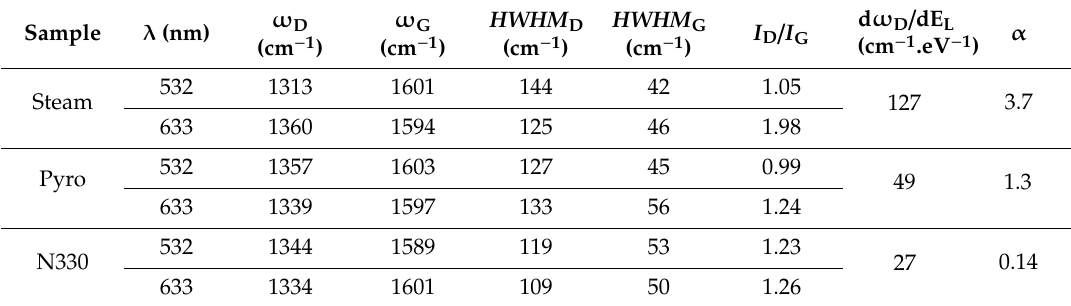
Figure 5. Raman spectra with their fitting (red lines are the components of the fit; blue lines are the resulting fit) for the three N330 samples (from top to bottom, the ranking is the same as in Figure 4). Left: green excitation; right: red excitation. Table 2. Fitting parameters corresponding to Figure 5. Wavelengths of 532 and 633 nm correspond to energy of 2.33 and 1.96 eV, respectively.